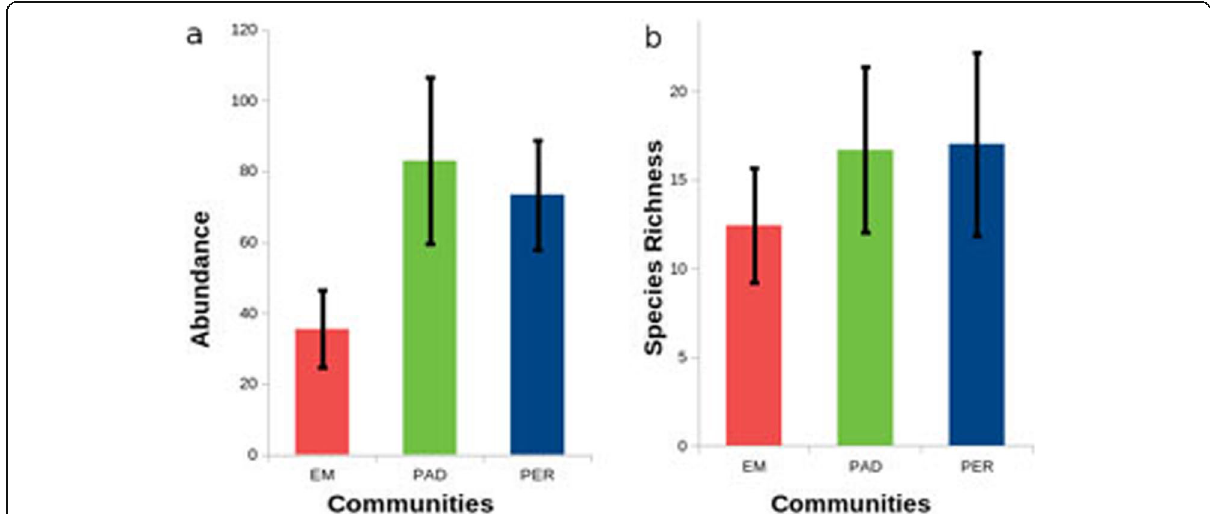
Fig. 3 Univariate measures of butterfly diversity and abundance across all the study sites (EM; Enmakaje, PAD; Padanakkad, and PER; Periye). From